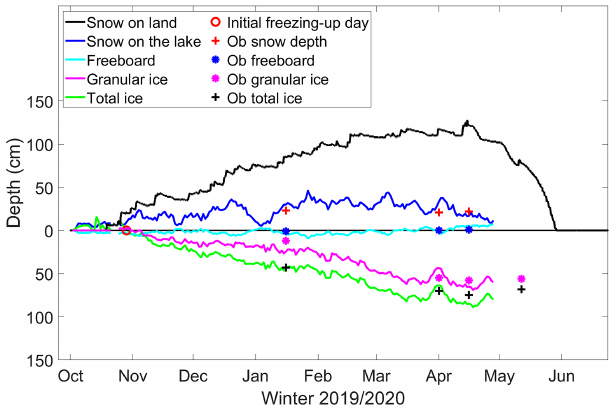
Figure 6. Products derived based on SIMBA data: snow depth (blue), ice freeboard (cyan), granular ice thickness (magenta), and total ice thickness (green). The symbols represent in situ observa- tions of snow depth (red cross), ice freeboard (blue dot), granular ice thickness (magenta dot), total ice thickness (black cross), and the initial freezing-up day (red circle). The black solid line denotes the snow depth on